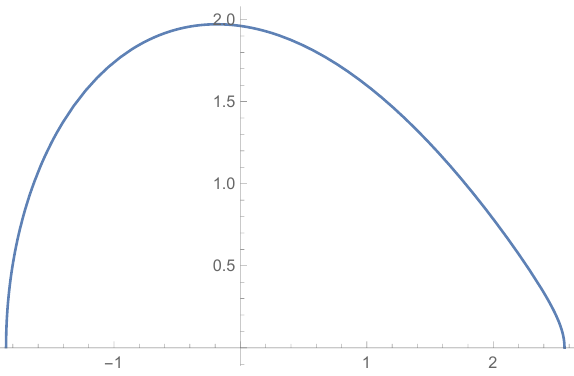
Figure 2 . The density ρ ( x ) given by (4.10) on the [ b, a ] cut for λ = 5 / 106 ≈ 0 . 047 , M = 1156 / 25 ≈ 46 . We chose the small value of λ and large M so that the density has a nontrivial profile substantially different from a